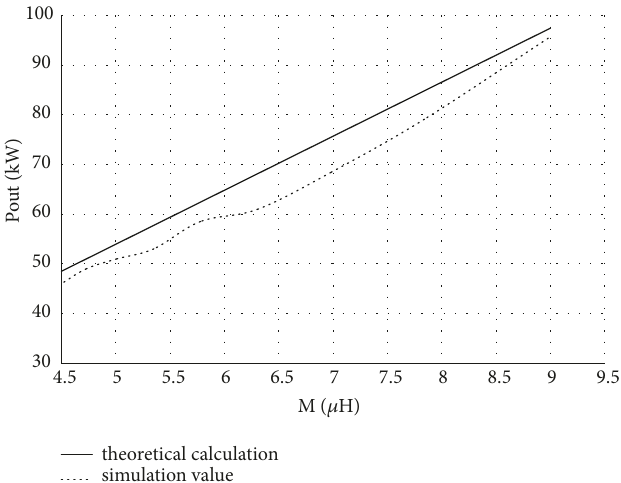
Figure 9: The output power of theoretical calculation and simulation value.